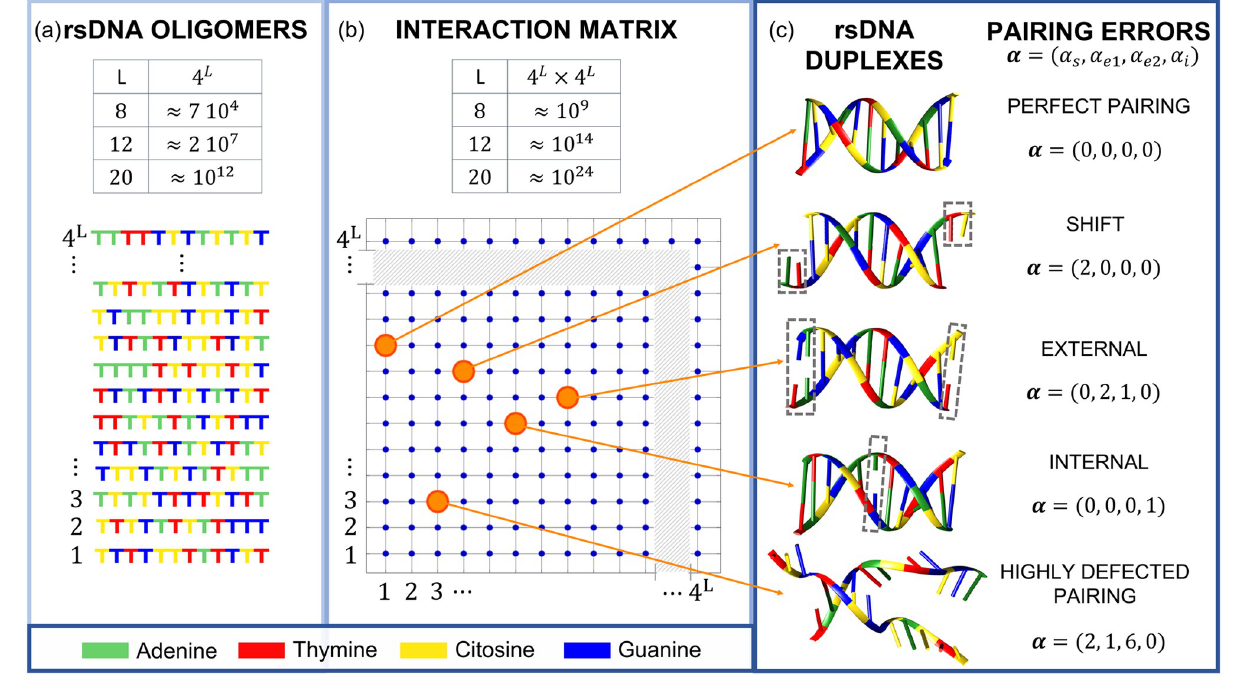
Fig 1. Description of the system. (a): Solutions of random-sequence DNA (rsDNA) oligomers of length L are mixtures made of 4 L distinct molecules, obtained by all the combinations of the four nucleobases, which are present at any position in the sequence with equal probability. (b): Each rsDNA oligomer can interact with 4 L different rsDNA oligomers, leading to a 4 L × 4 L interaction matrix. Each dot in the matrix represents the most energetically favorable pairing between the two selected rsDNA oligomers, among all the possible mutual shifts. (c) Each position in the interaction matrix corresponds to a specific duplex motif, characterized by pairing errors which are here described by the parameters in α . The most probable duplex in the matrix is highly defected, as the last example in the panel.